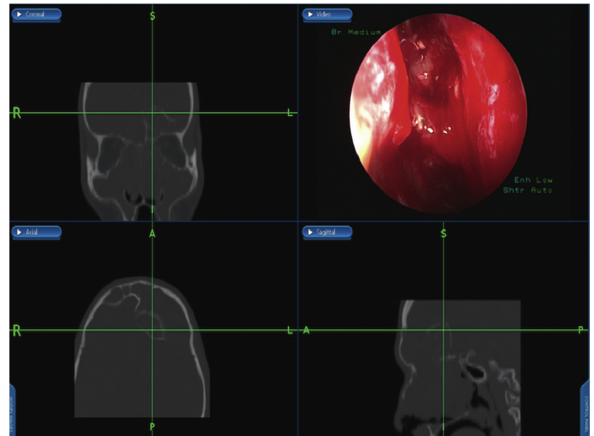
Figure 7: Draf type 2b performed, mucopyoceles cavities full of pus irrigated with antibiotic-soaked irrigations.